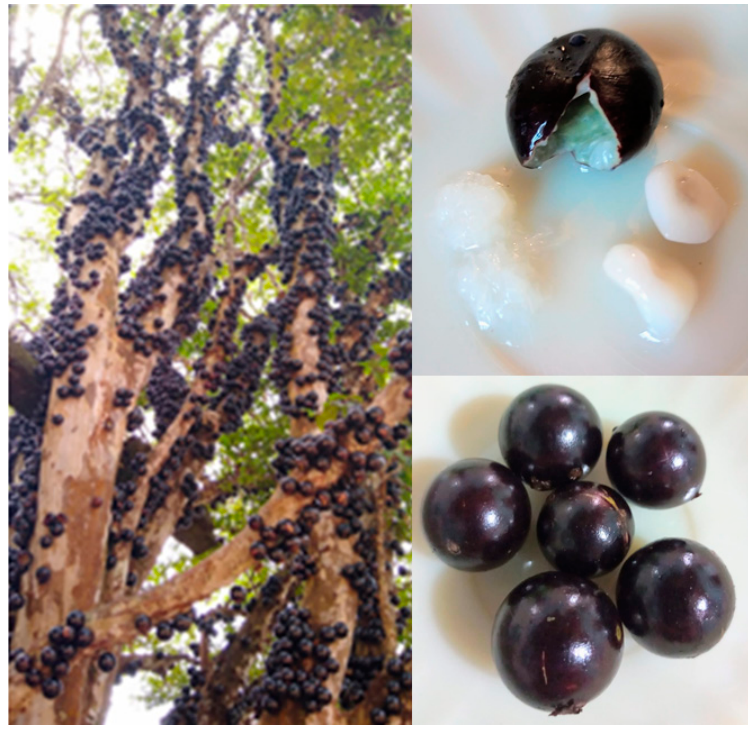
Figure 1. Photographs of jabuticaba fruits.